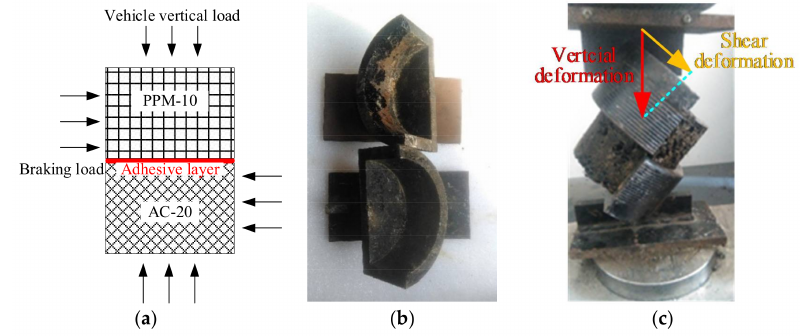
Figure 2. Illustration of inclined shear test: ( a ) Force on the specimen; ( b ) shear clamps; and ( c ) test setup with